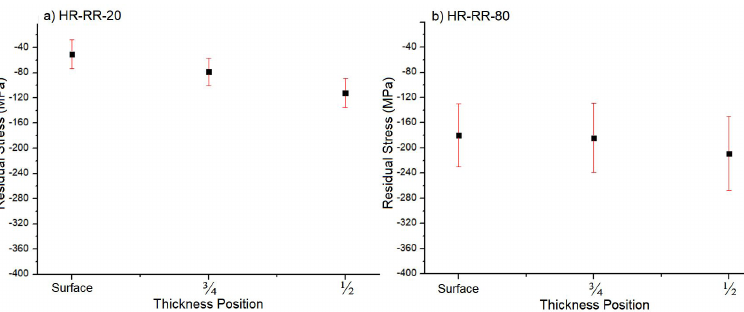
Figure 3. Residual stress profile of the austenite in HR-RR-20 sample (a) and α’-martensite phase in HR-RR-80 sample (b).